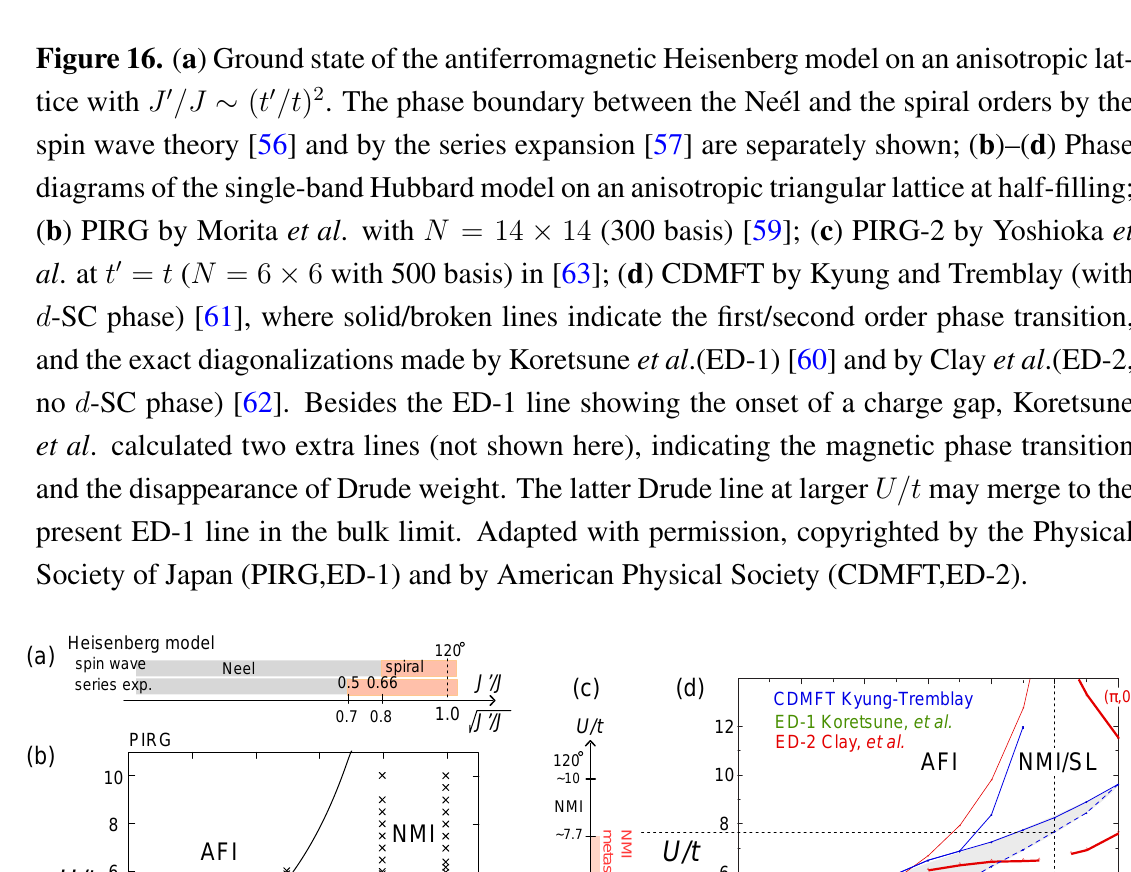
Figure 16. ( a ) Ground state of the antiferromagnetic Heisenberg model on an anisotropic lat- tice with J (cid:48) /J ∼ ( t (cid:48) /t ) 2 . The phase boundary between the Ne´el and the spiral orders by